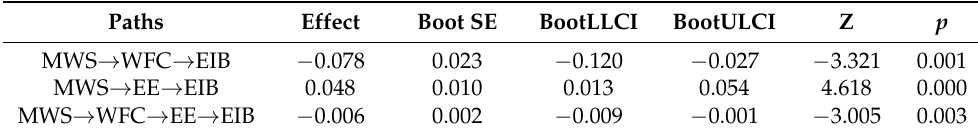
Table 5. Test results of the two-factor analysis with causal mediation model.